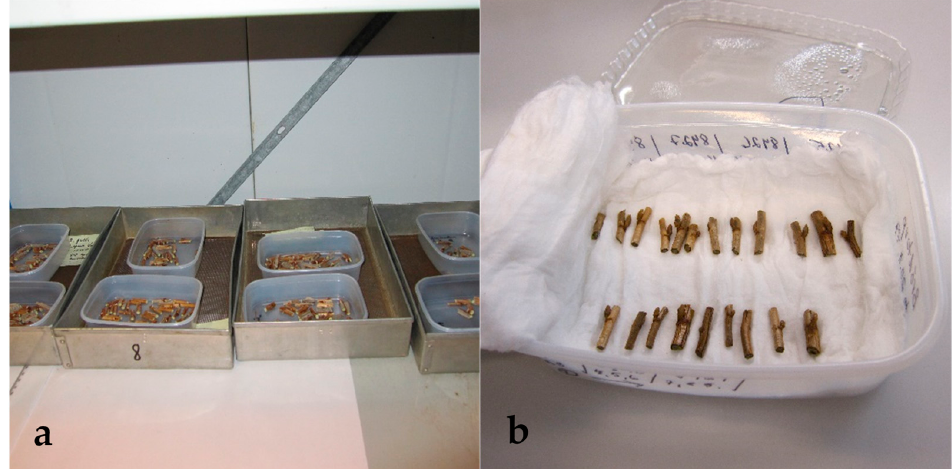
Figure 4. The experimental set-up of the protocol experiment for blackcurrant cvs. Marski, Mikael, and Vilma. Of 160 bud sections of each cultivar, 80 bud section were dehydrated before cryopreservation, and 80 bud sections were cryopreserved without dehydration. Cryopreserved bud sections were thawed either slowly at 2 °C or fast in a water bath at 38 °C, and thereafter rehydrated for 7 days or 14 days. Each treatment combination included 20 bud sections.